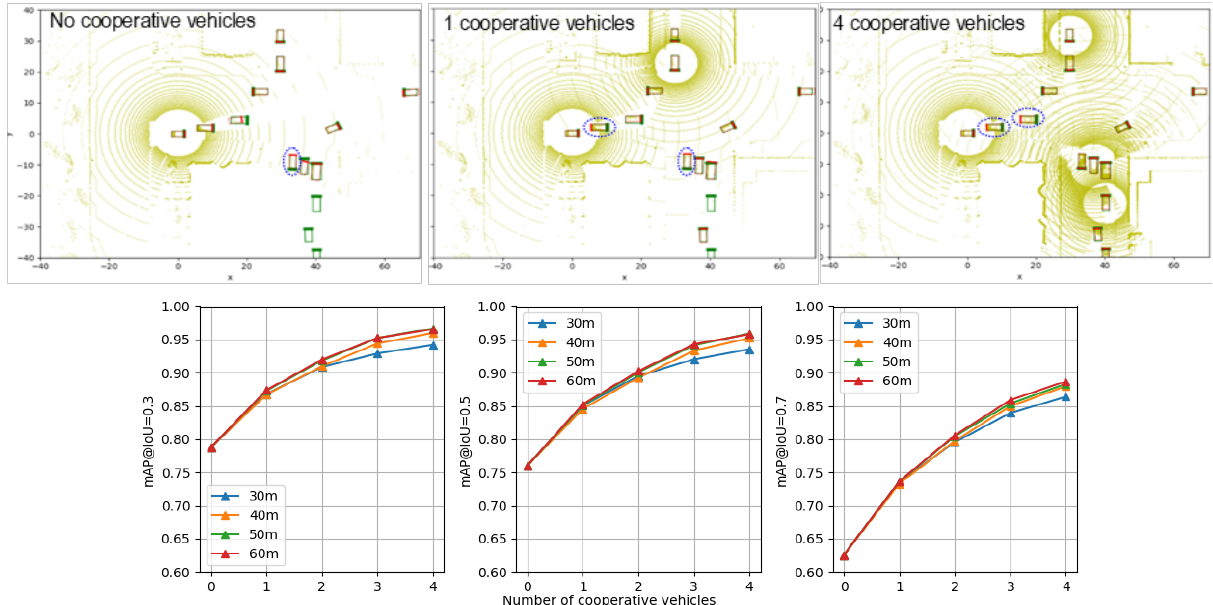
Figure 5. The vehicle detection performance of CIA-SSD. Top: detection result with/without cooperative vehicles, green indicates ground truth, red indicates predictions, the thick bar of each box tells the box orientation; Bottom: three plots show mAPs calculated with three IoU thresholds, each one shows the results with a different number of cooperative vehicles (horizontal axes, vary from 0 to 4) and communication ranges (plotted in different colors, vary from 30m to